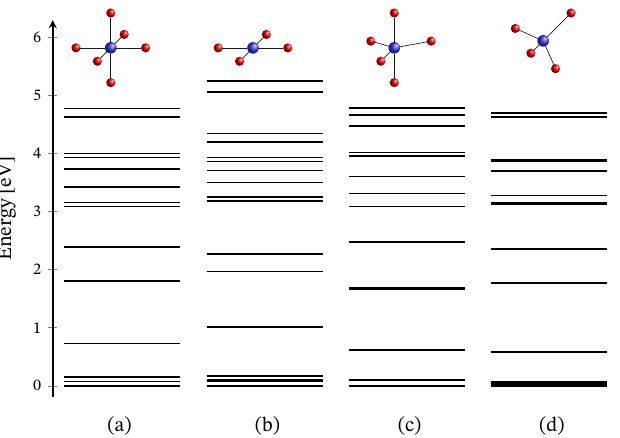
Figure 1. Zero-field energy spectra of four Ni 2 + coordination complexes. Subfigures ( a – d ) represent the cases of octahedral, square planar, trigonal bipyramidal and tetrahedral geometry, respectively. The values of all parameters are given at the end of Section 2.1. At the given energy scale, each line represents a set of sublevels. The bolder a line, the larger the number of sublevels; see the numerical representation of these spectra in the Supplementary materials, Section S6.